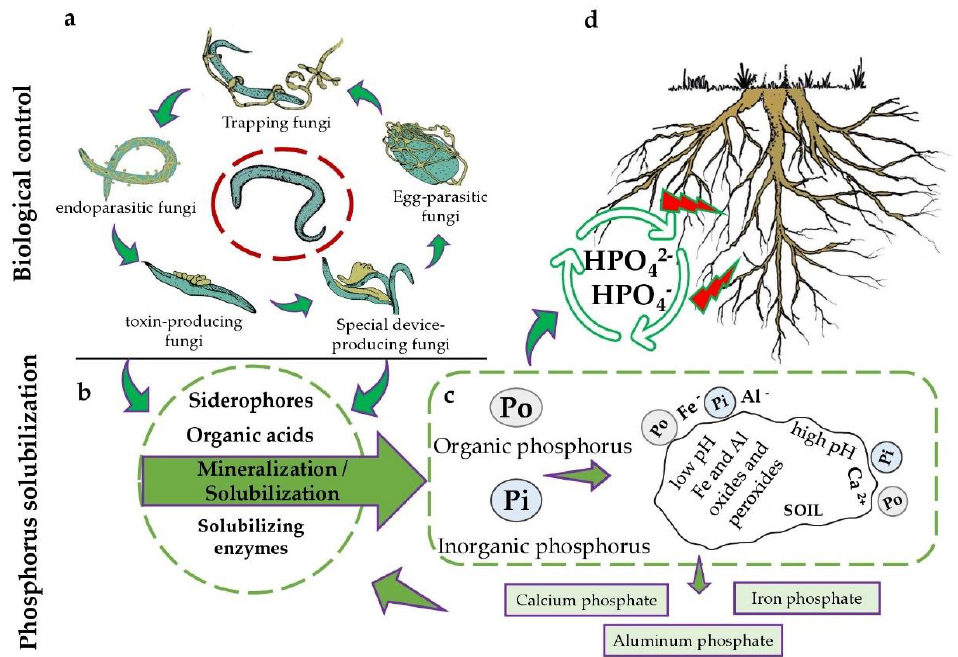
Figure 1. Systematic diagram of P solubilization by fungi used in the biological control of nematodes. ( a ) Nematodes can be parasitized and predated by (in clockwise order) trapping fungi, egg-parasite fungi, special device-producing, or toxin-producing and endoparasitic species. ( b ) Compounds produced by fungi. ( c ) Chemical reactions of P in soil, binding with elements such as calcium, iron, and aluminum that can then be mineralized or solubilized by the NF compounds. ( d ) Roots absorbing negatively charged orthophosphate